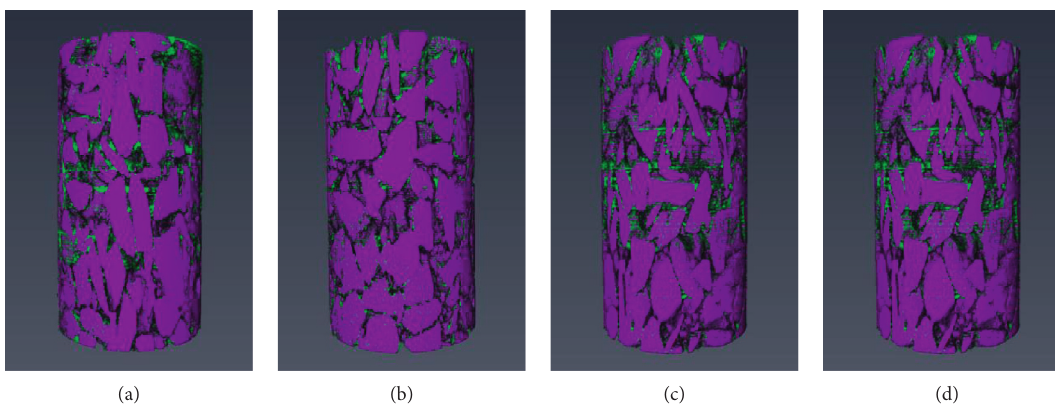
Figure 8: 3D visualization of PUPM 8-H at the clogging period of (a) 20, (b) 40, (c) 60, and (d) 80minutes Table 1: Void content distribution measurements for PUPM specimens at 20, 40, 60, and 80min clogging simulation. Specimens